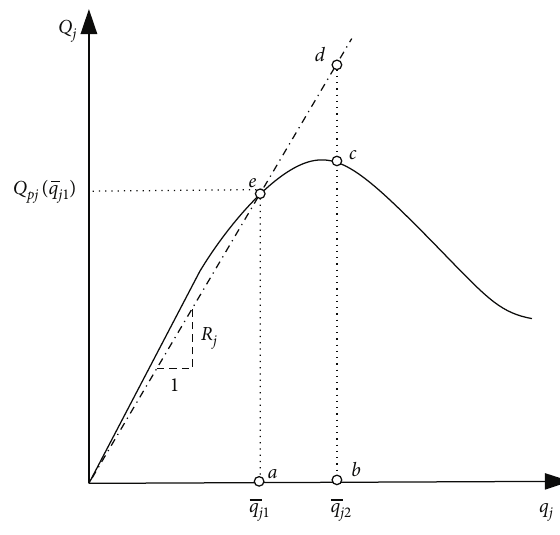
Figure 3: Schematic for area